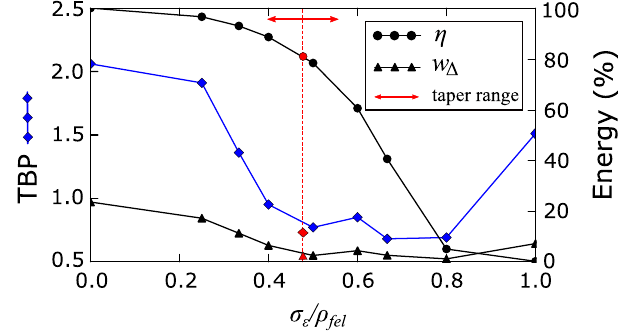
FIG. 6. Effect of the beam energy spread σ ϵ on the relative energy in the main peak E (black circles), on the fractional tail loss energy w Δ (black triangles) and on the pulse r.m.s. time bandwidth product (blue squares). The red symbols represent the same parameters in presence of tapered energy spread ¼ 4% . The red according to the rule given in Eq. (7), with α t dashed line is centered on the range spanned by the local value of the energy spread during the pulse evolution. This range is indicated by the horizontal red-arrow.